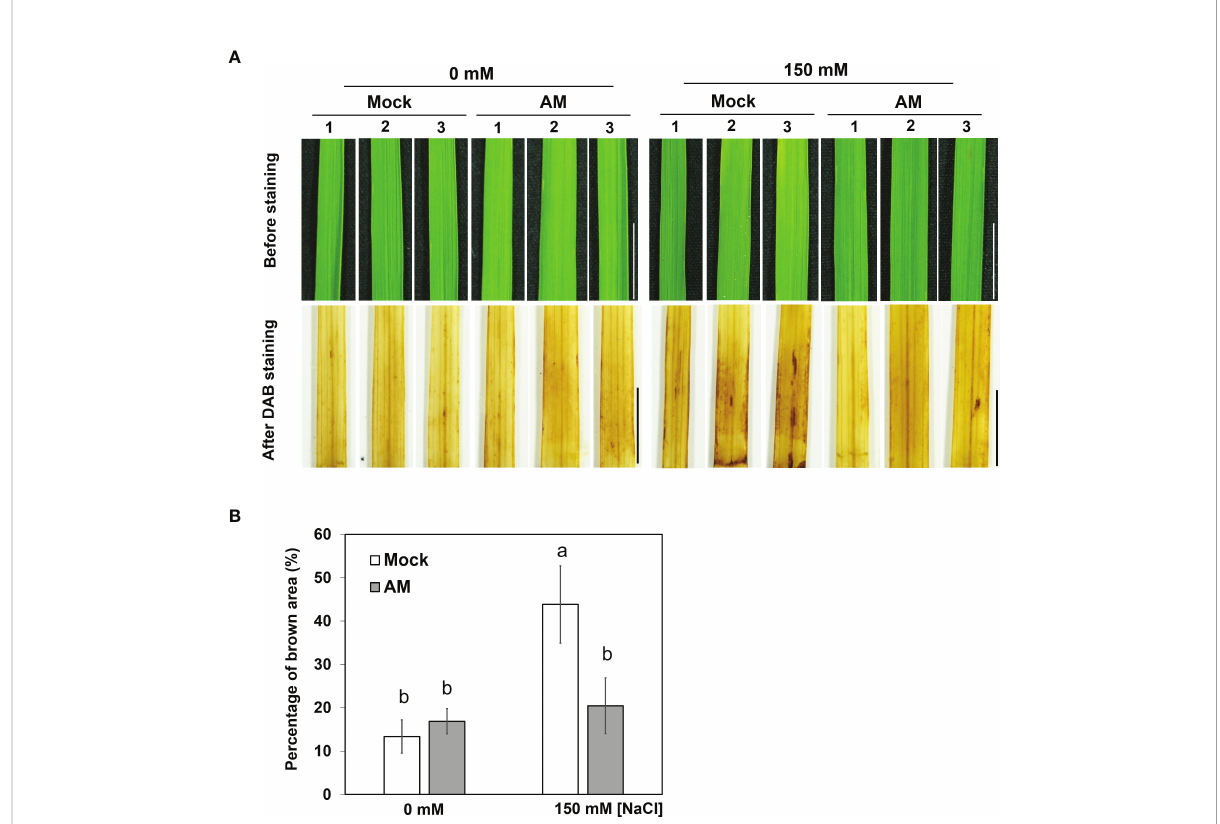
FIGURE 2 DAB staining in rice shoots under salt stress (A) Accumulation of H 2 O 2 visualized in leaf blades by DAB staining after 3 weeks of salt stress. The eighth fully expanded leaves from 5-6 plants were detached and incubated in DAB solution for 16 hrs, and representative leaves from 3 plants are presented. Mock, nonmycorrhizal plants; AM, mycorrhizal plants inoculated with R. irregularis . Scale bar = 1 cm. (B) The percentage of brown area (the area of brown spots divided by the area of whole leaf) of DAB staining was quanti fi ed by using ImageJ. The standard error was derived from 5-6 biological replicates (one plant was considered one biological replicate). Different letters represent signi fi cant differences at p < 0.05 (two-way ANOVA followed by a least signi fi cant differences post hoc